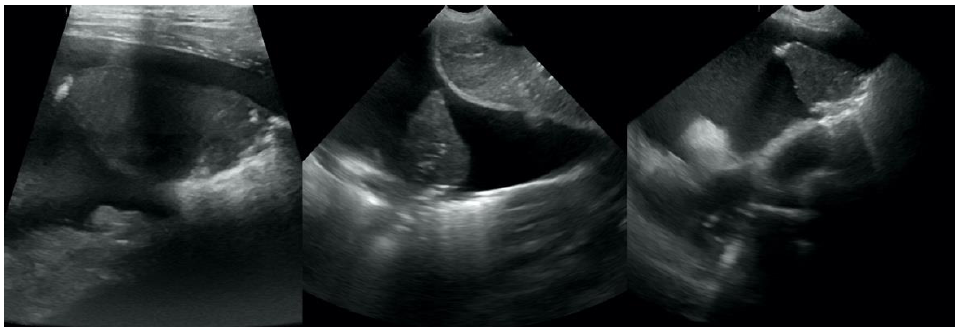
Figure 10. Hepatization in the course of lung cancer and free fluid in thorax cavity. The presence of normal, unchanged pleural line and A-lines with a lung sliding was considered as normal, aerated lung, and all these patients were excluded from the further